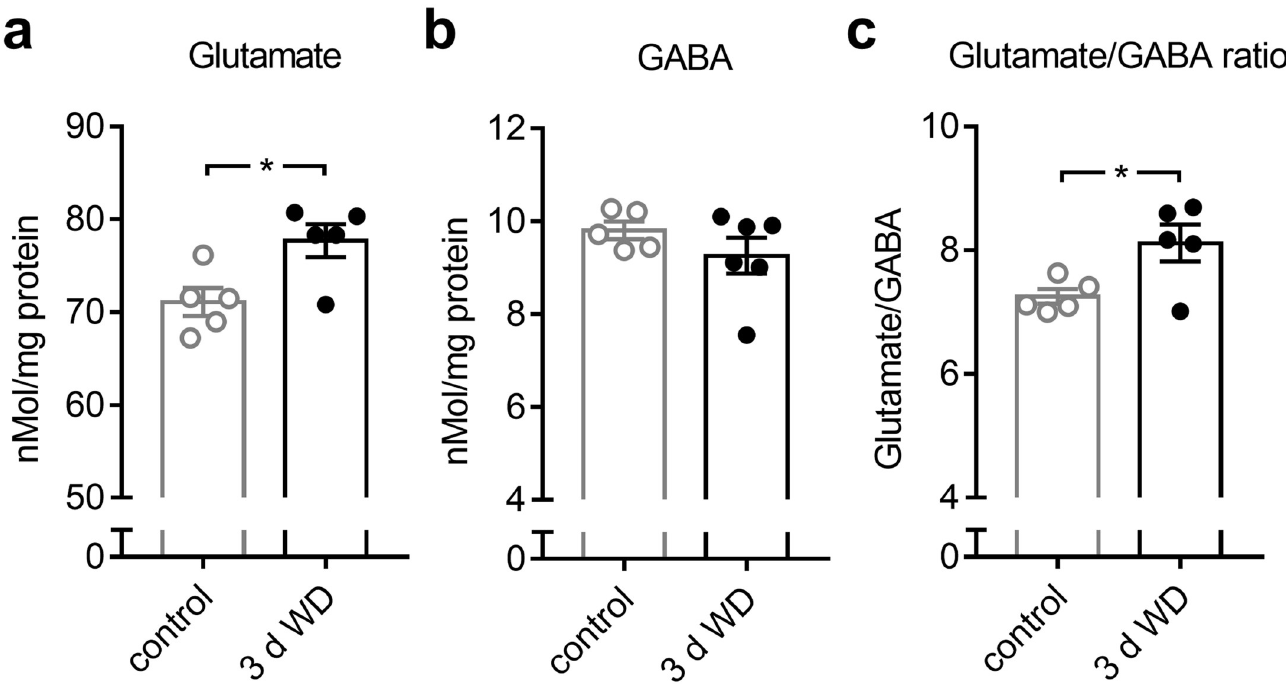
Fig 8. Concentration changes of neurotransmitters in V1 after WD revealed by post-mortem HPLC analyzes. ( a ) Compared to the V1 glutamate level of control mice (n = 5), there was a significant increase of V1 glutamate content 3 days after WD (n = 5). ( b ) There was slight but not significant reduction of the V1 GABA concentration at 3 days after WD (n = 6) compared to controls. ( c ) The glutamate/GABA ratio was markedly increased at 3 after WD. Bars represent means together with s.e.m., Open and filled circles represent measurements of individual animals; � p < 0.05.